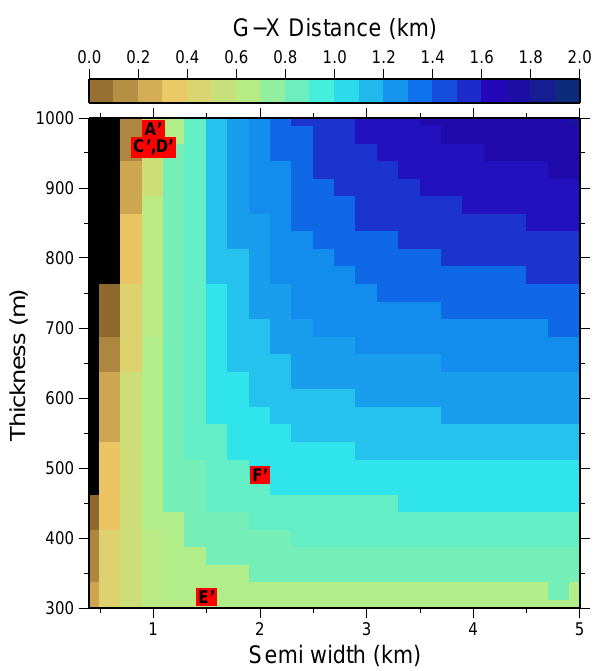
Figure 18. G–X distance (km) as a function of the ice slab thickness and the semi width of the forcing pattern. The five kinematic GPS control points A 0 , C 0 , D 0 , E 0 and F 0 are here placed according to their specific parameter combinations. For display purposes, point A 0 (1050m ice thickness) had to be lowered to